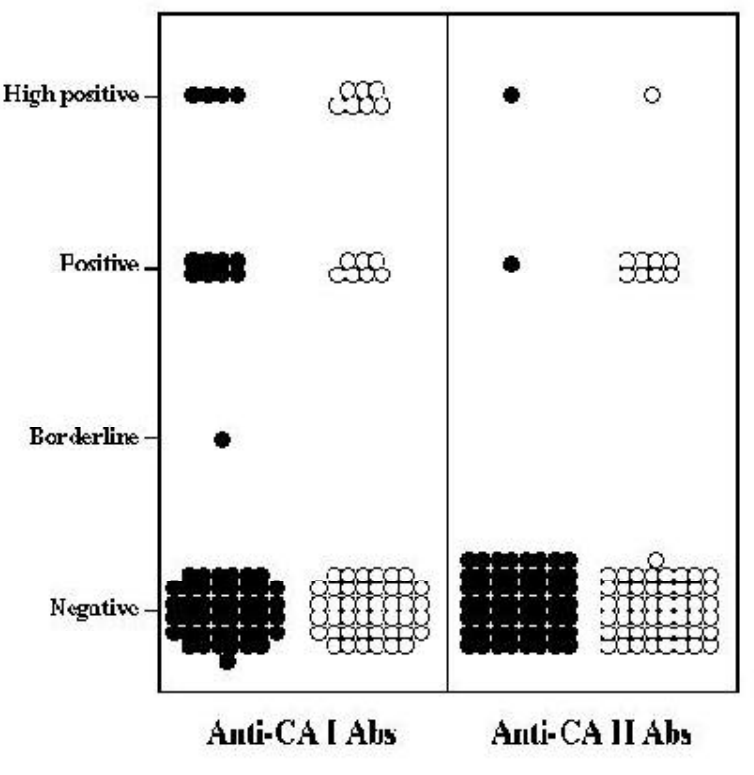
FIGURE 2. Positive sera for anti-CA-I and -CA-II Abs from patients with alcoholic CP (black circles) vs. nonalcoholic CP (white circles). Negative sera were considered when absorbance values were below the mean absorbance +2 SD of HD sera. Those lectures between the mean absorbance +2 SD and the mean absorbance +3 SD were considered borderline. A serum was considered positive when the absorbance value was above the mean absorbance +3 SD, whereas it was considered high positive when the lecture was above the mean absorbance +5 SD of HD